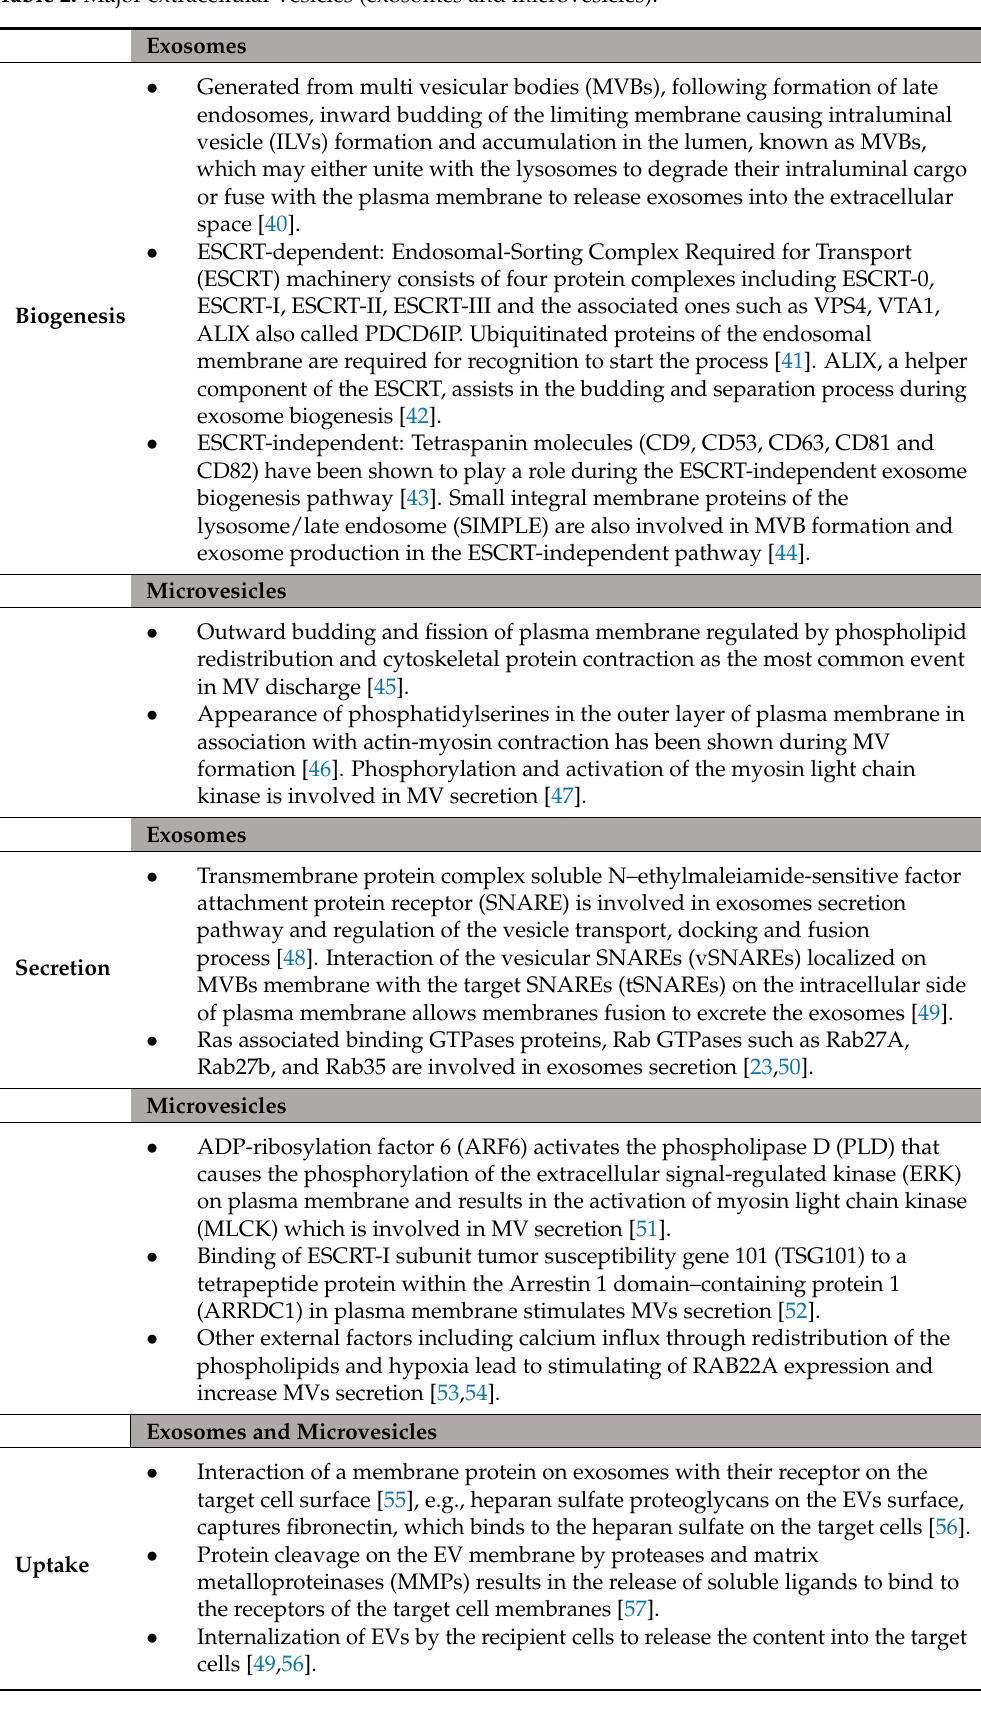
Table 2. Major extracellular vesicles (exosomes and